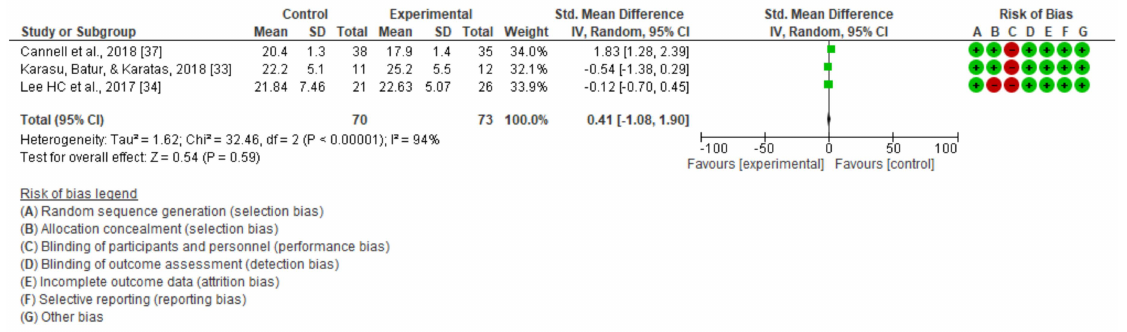
Figure 4. Static balance as measured using the functional reach test.